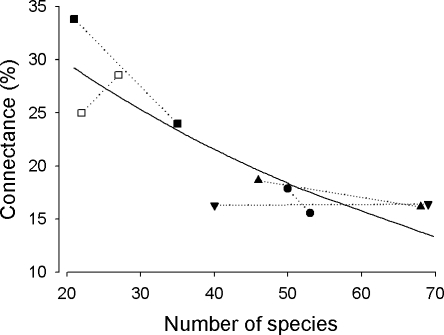
Relation of Connectance to the Number of SpeciesConnectance represents the percentage of possible interactions that were actually recorded. The solid line indicates the best-fit negative exponential regression line (y = 40.9 × e
–0.016x, F = 221.6, df = 2, 8, p < 0.0001). N = 10 pollination webs. Symbols as in Figure 1.